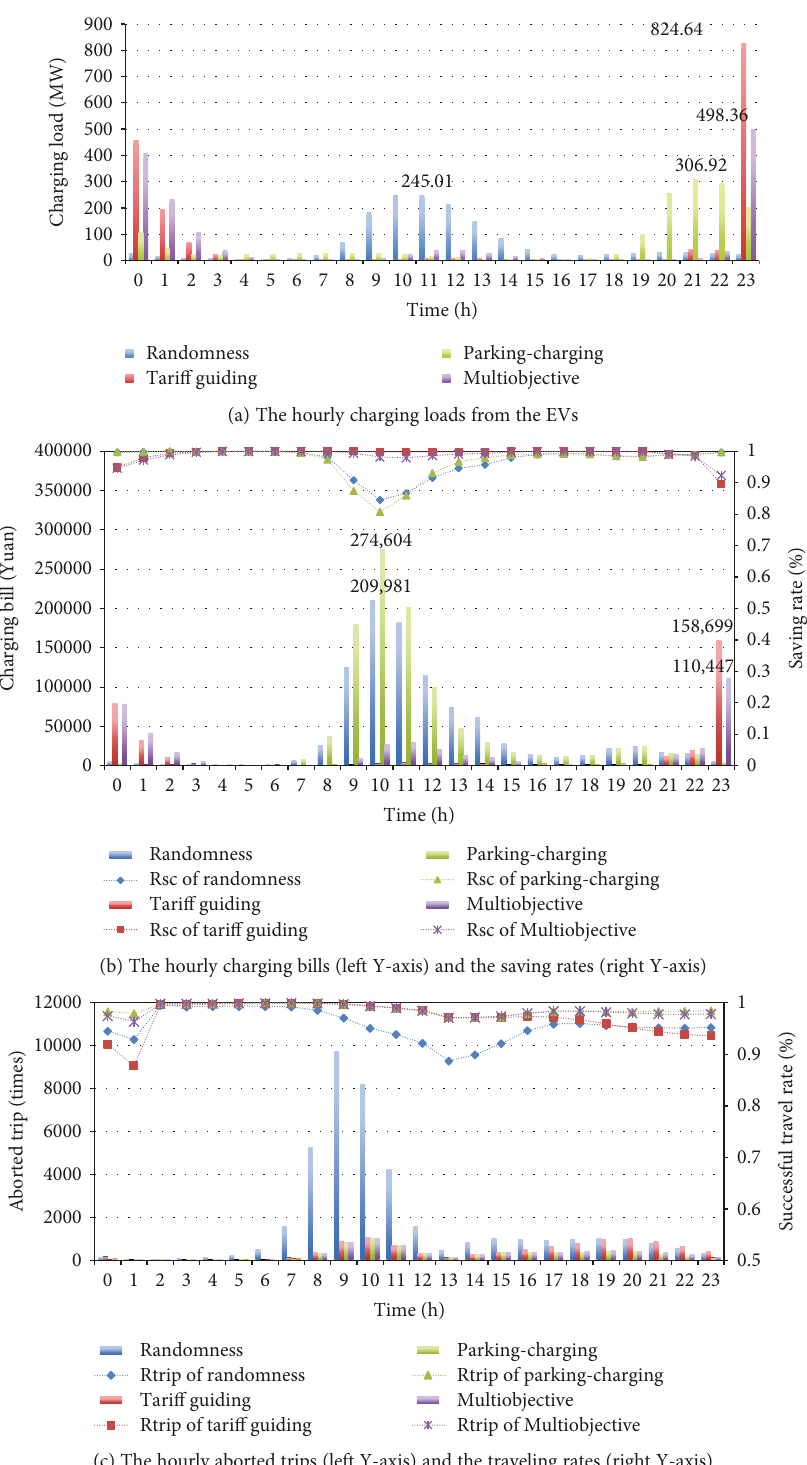
Figure 10: Index comparison of the hourly charging under four di ff erent charging